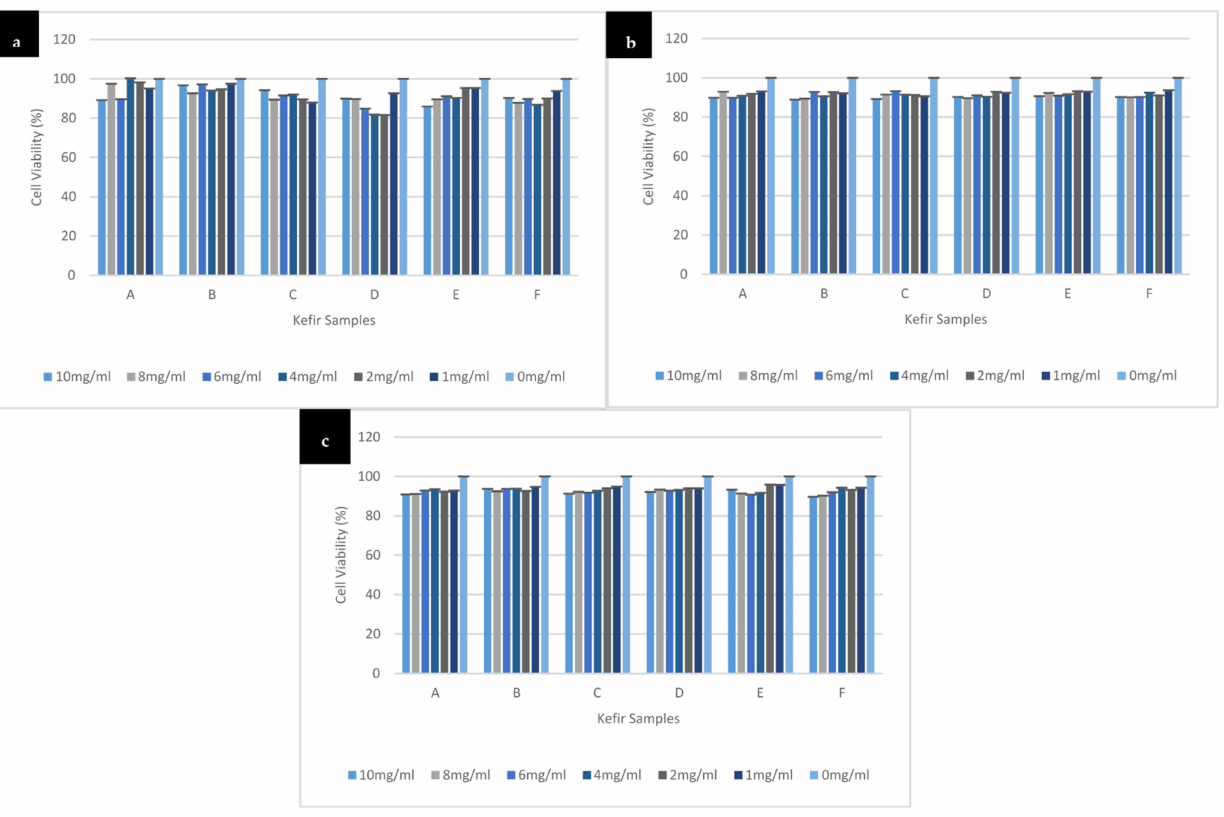
Figure 2. Cytotoxicity of kefir water samples (A–F) on differentiated SH-SY5Y cells at different concentrations (1 to 10) mg/mL. Displayed kefir water treatment at ( a ) 24 h, ( b ) 48 h, and ( c ) 72 h. The experiment was carried out in triplicates and values are presented in means ±